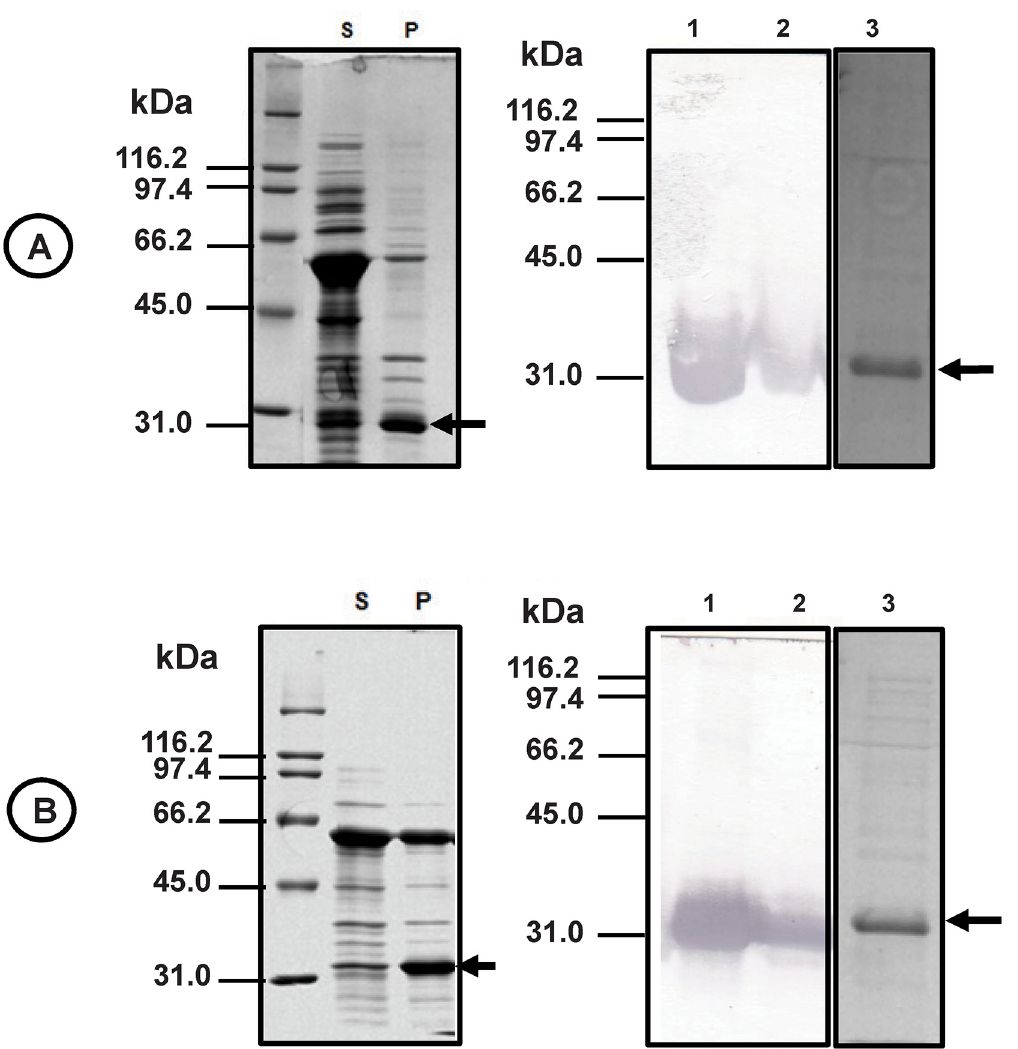
Fig 1. Expression and purification of Sf β gly-N and Sf β gly-C. Proteins from the soluble (lane S) and insoluble (lane P) fractions of bacteria (ArticExpress (DE3)) induced to produce Sf β gly-N (A) and Sf β gly-C (B) were analyzed by SDS – PAGE (12% polyacrylamide; Comassie Blue R250 staining), transferred to a nitrocellulose membrane and immuno-detected using anti-His 6 antibody (lanes 1 and 2, respectively). Sf β gly-N and Sf β gly-C were purified from the respective soluble fractions using Ni-NTA agarose and analyzed by SDS – PAGE (lane 3; arrow; Comassie Blue R250